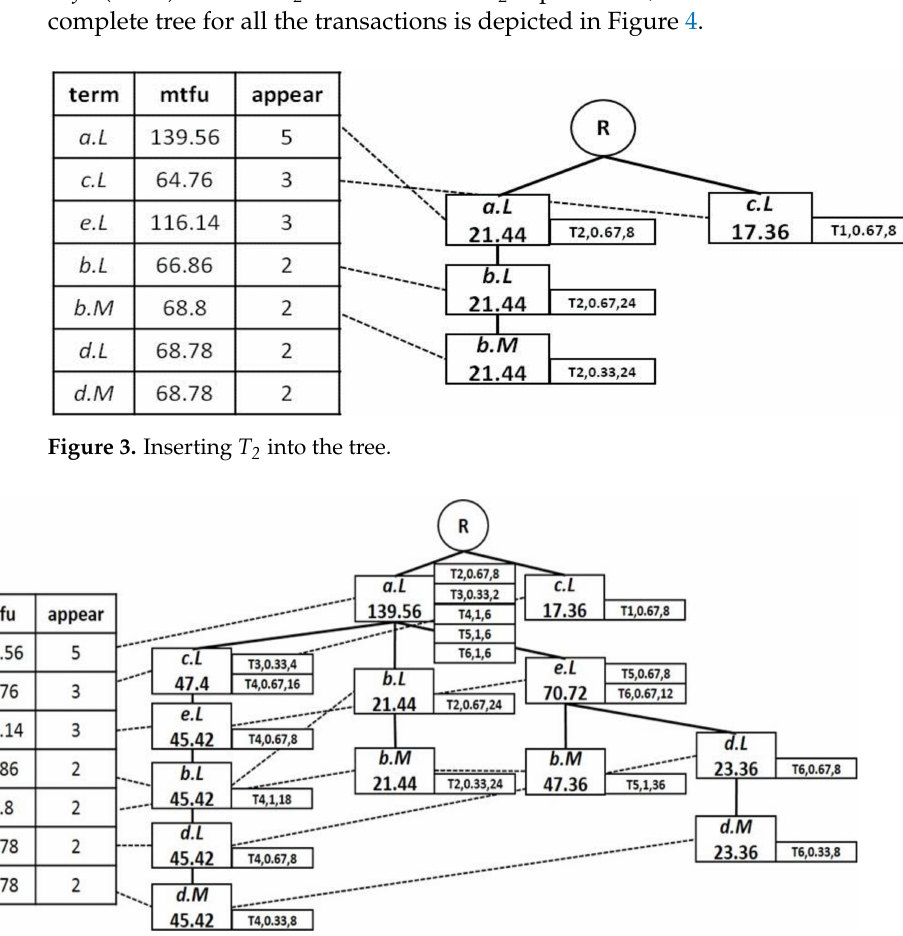
Figure 4. The complete